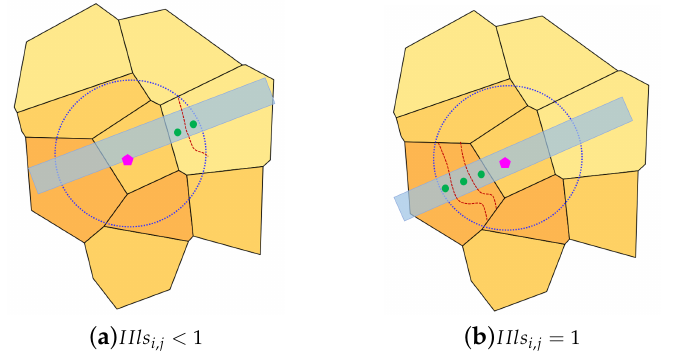
Figure 7. Display of two types of impact of a landslide on a